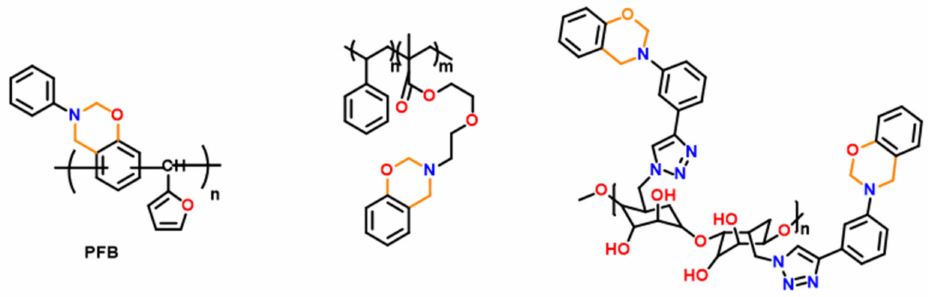
Figure 24. Representative side-chain benzoxazine linked polymers [229,232,235].